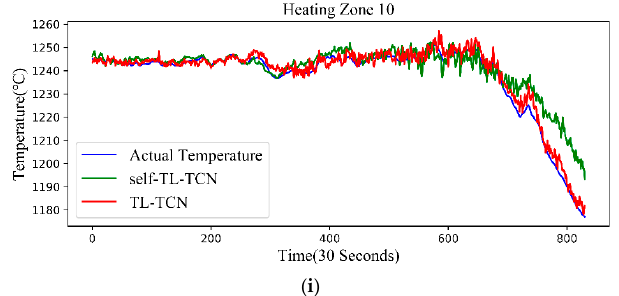
Figure 17. No transfer learning means that we do not use transfer learning to complete the prediction, but we use self-transfer learning to change the initial weight of the neural network. TL-TCN refers to the method with better results in fine-tuning and GAN-TCN, ( a – i ) shows the comparison of prediction results of heating zone 2–10.